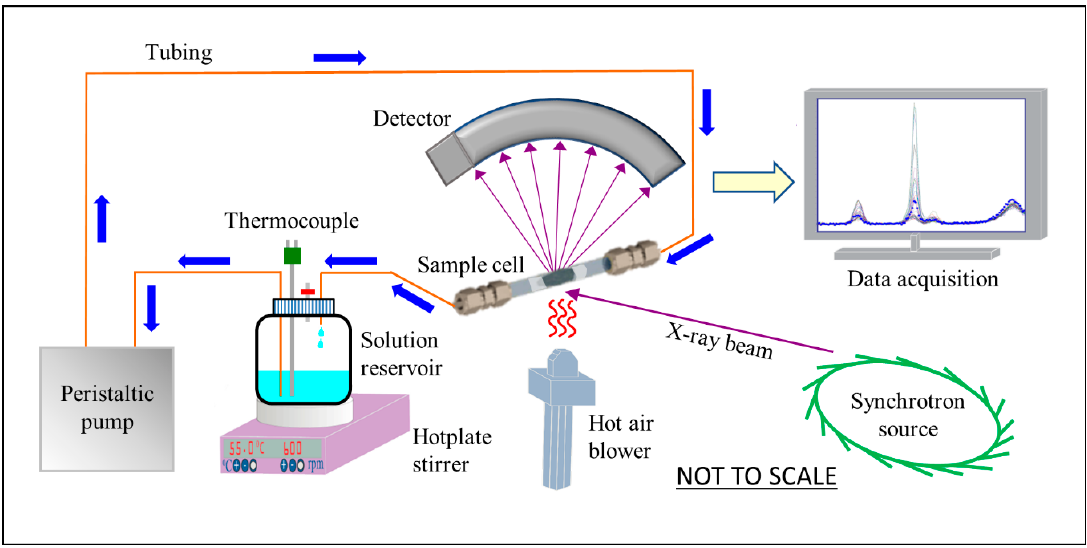
Figure 1. Schematic diagram of the flow-through cell experimental apparatus. Blue arrows show the flow direction.